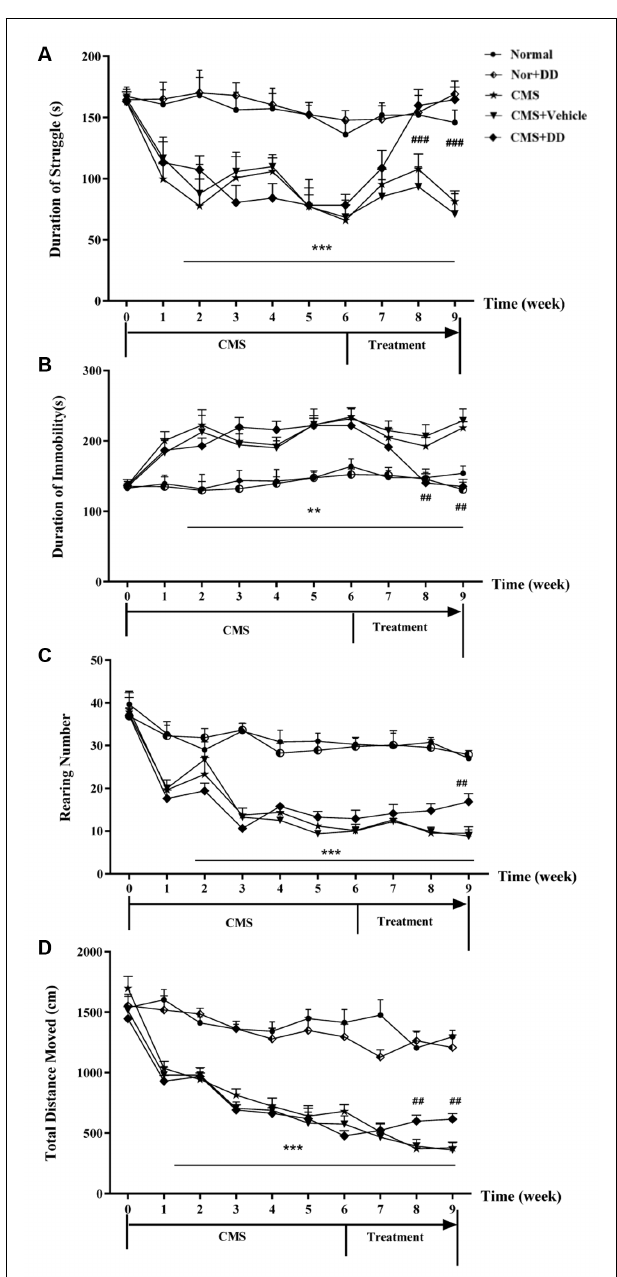
FIGURE 3 | Chronic administration of daidzein relieved depression-like behaviors in CMS mice. (A) CMS mice spent significantly less time struggling in the forced swimming test (FST) compared to normal mice, while daidzein contradicted the effect of CMS on the despair behavior compared to CMS mice. (B) Daidzein showed an antidepressant effect on CMS mice in tail suspension test (TST). (C) Chronic mild stress (CMS) induced impaired explorative behavior and the decreased rearing number in OFT compared to normal mice which was relieved by DD. (D) The total moving distance of the rats in the open field test was also significantly decreased in CMS mice compared with that of the normal group, which suggested improvement brought about by daidzein treatment. Whereas, DD displayed no obvious effect on the behavior of normal rats. ** p < 0.01, *** p < 0.001, ## p < 0.01, ### p <